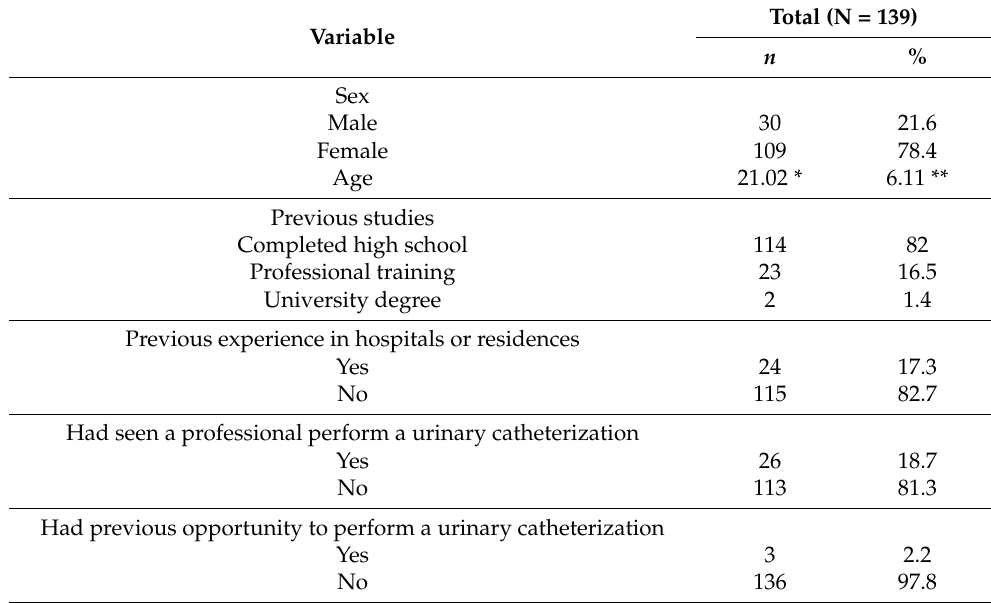
Table 1. Socio-demographic characteristics of the